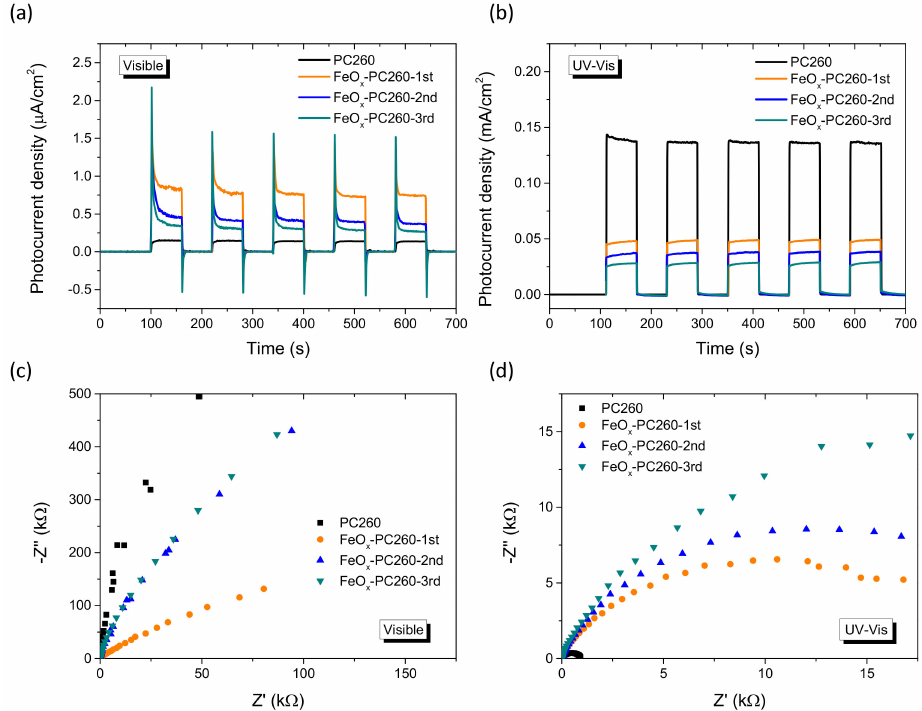
Figure 6. Transient photocurrents under chopped light and EIS Nyquist plots for ( a , c ) visible and ( b , d ) UV-Vis illumination for the FeO x –PC260